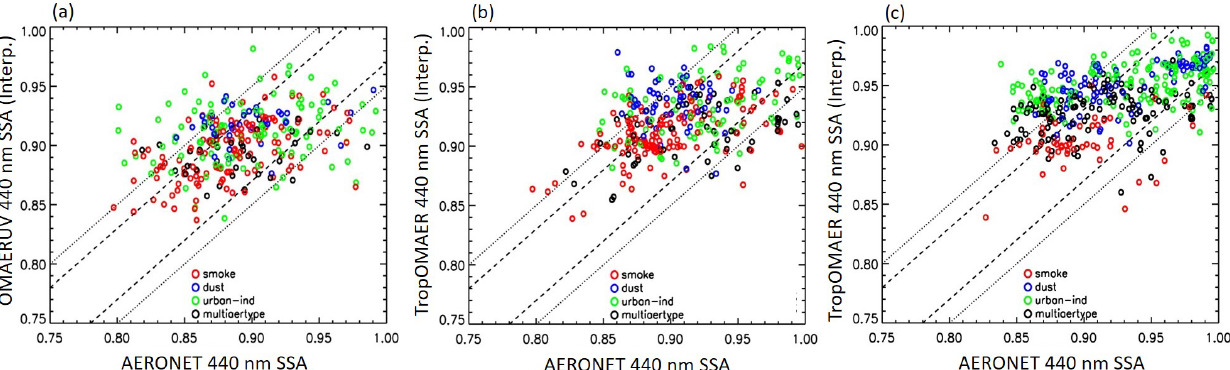
Figure 4. As in Fig. 3 for single-scattering albedo of dust aerosols (blue), smoke aerosols (red), urban–industrial aerosols (green), and aerosol mixtures (black). The dashed line indicates agreement ± 0.03, and the solid line indicates agreement ±